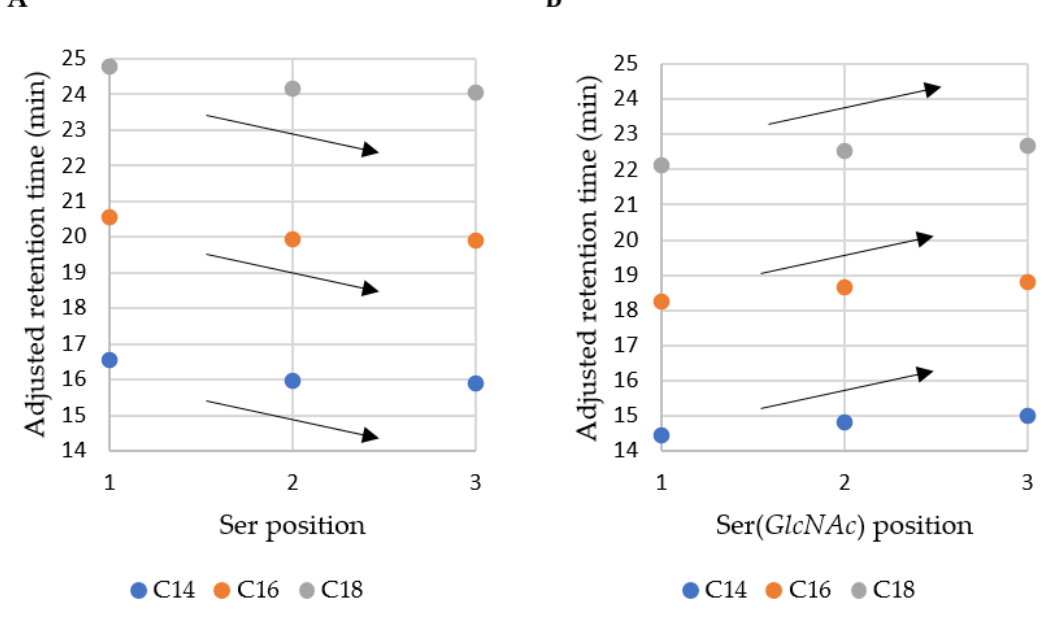
Figure 1. Adjusted retention time of lipopeptides vs. position of ( A ) Ser and ( B ) Ser( GlcNAc ).